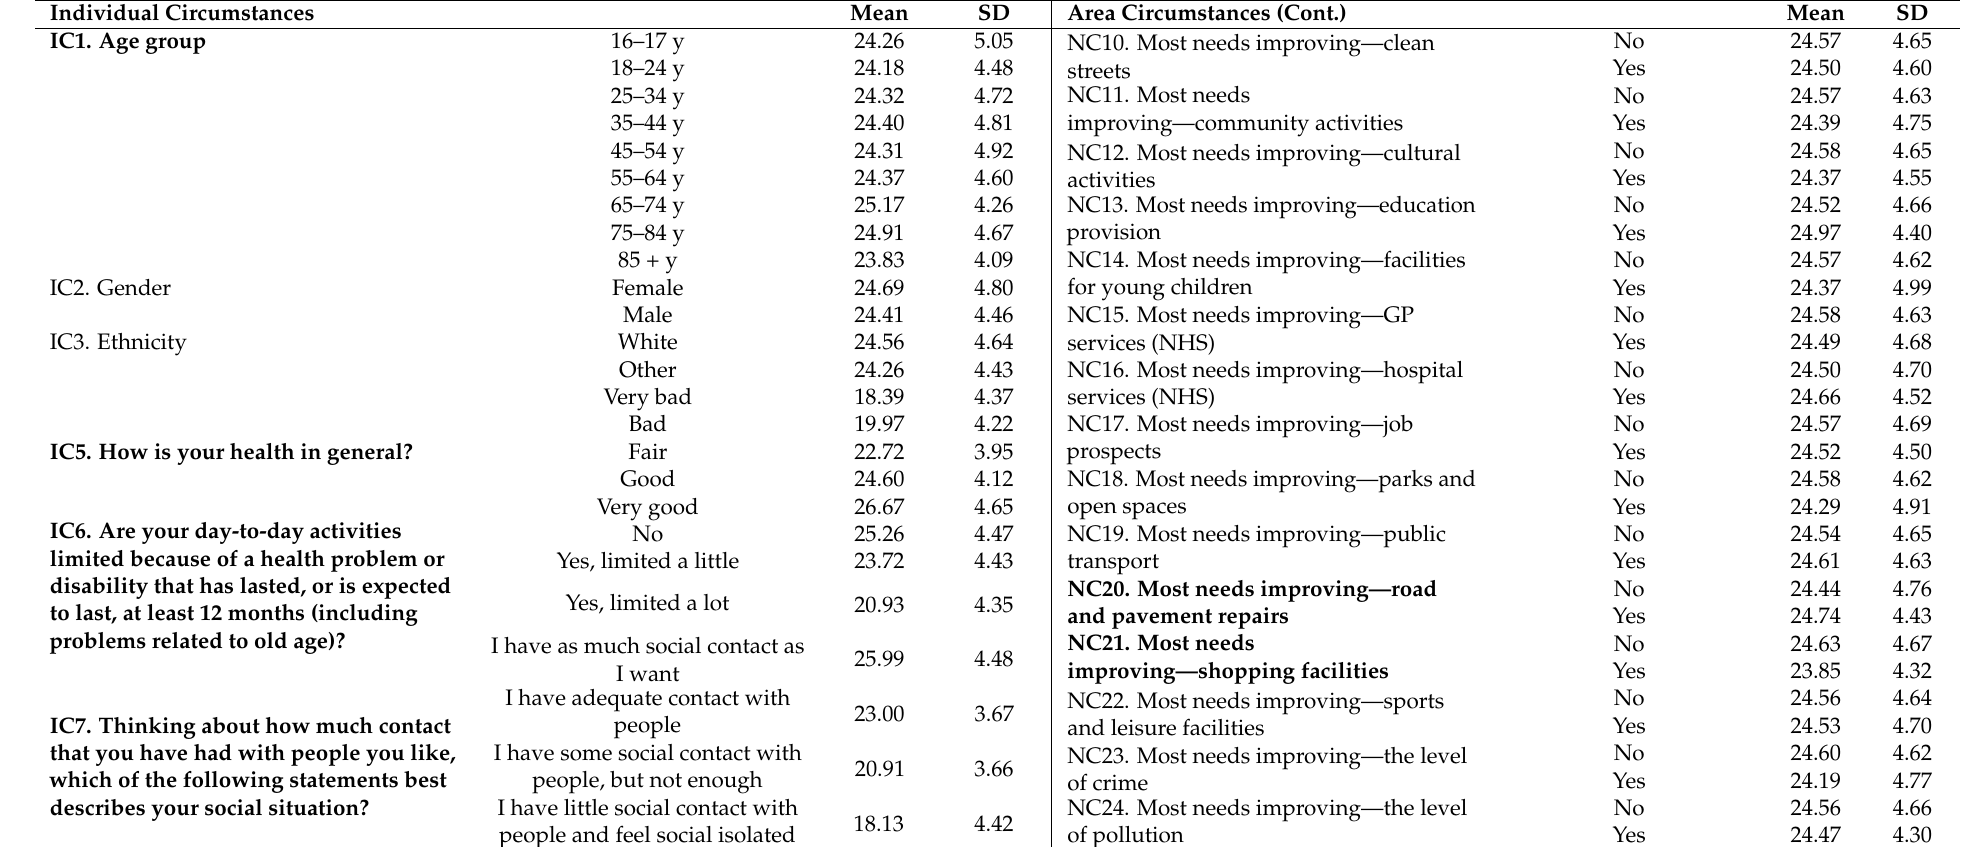
Table A3. Mean mental wellbeing (SWEMWBS) score by survey response to individual, living, and neighbourhood circumstance variables for the complete sample ( n =